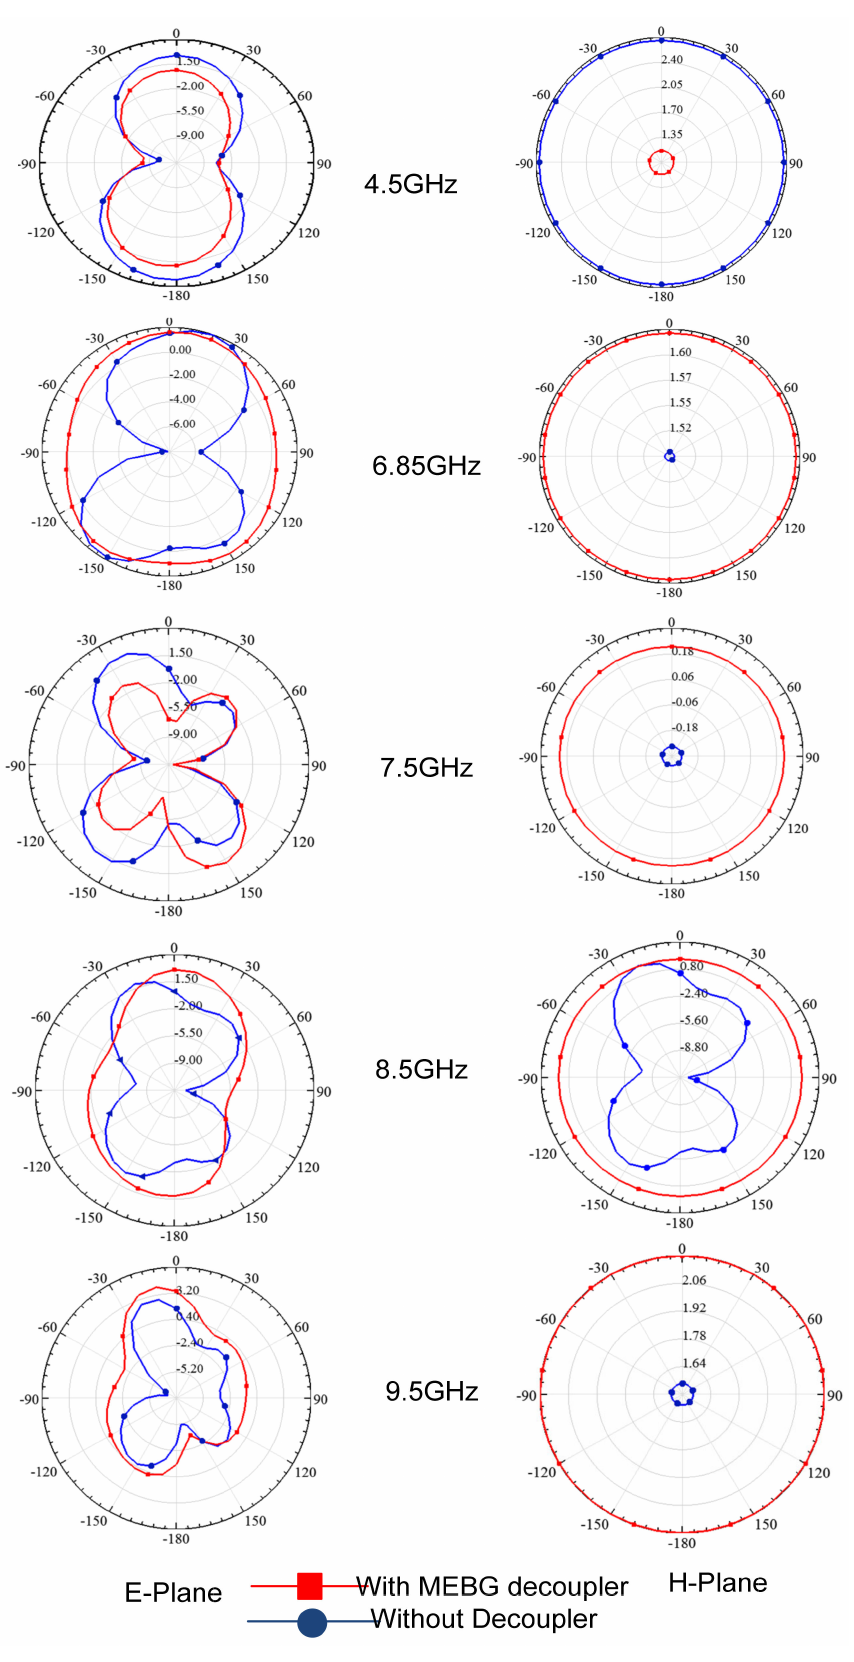
Figure 12. Radiation pattern at 4.5 GHz, 6.85 GHz, 7.5 GHz, 8.5 GHz, 9.5 GHz